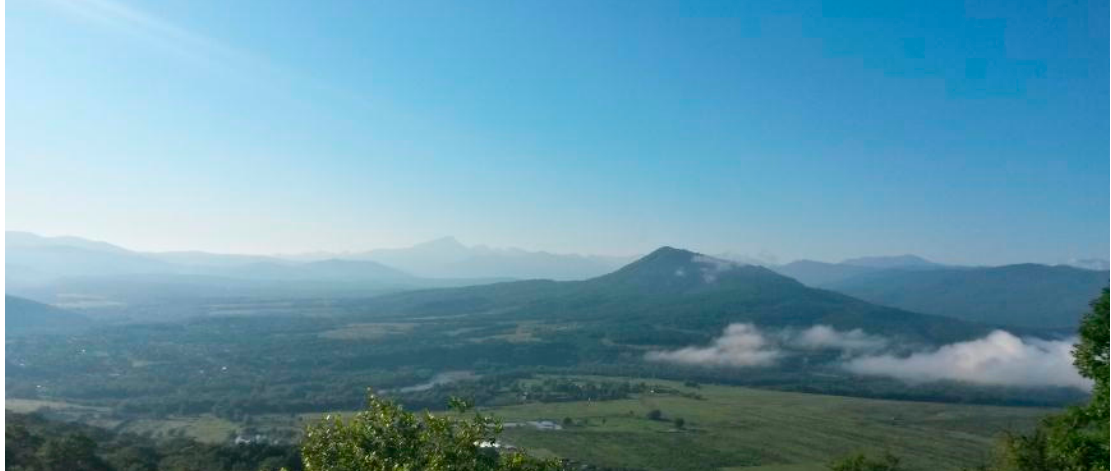
Figure 2. The Azish-Tau 4500 viewpoint geosite displaying landforms created by partly differential neotectonic uplift of the Western Caucasus (photo by A.V. Mikhailenko).